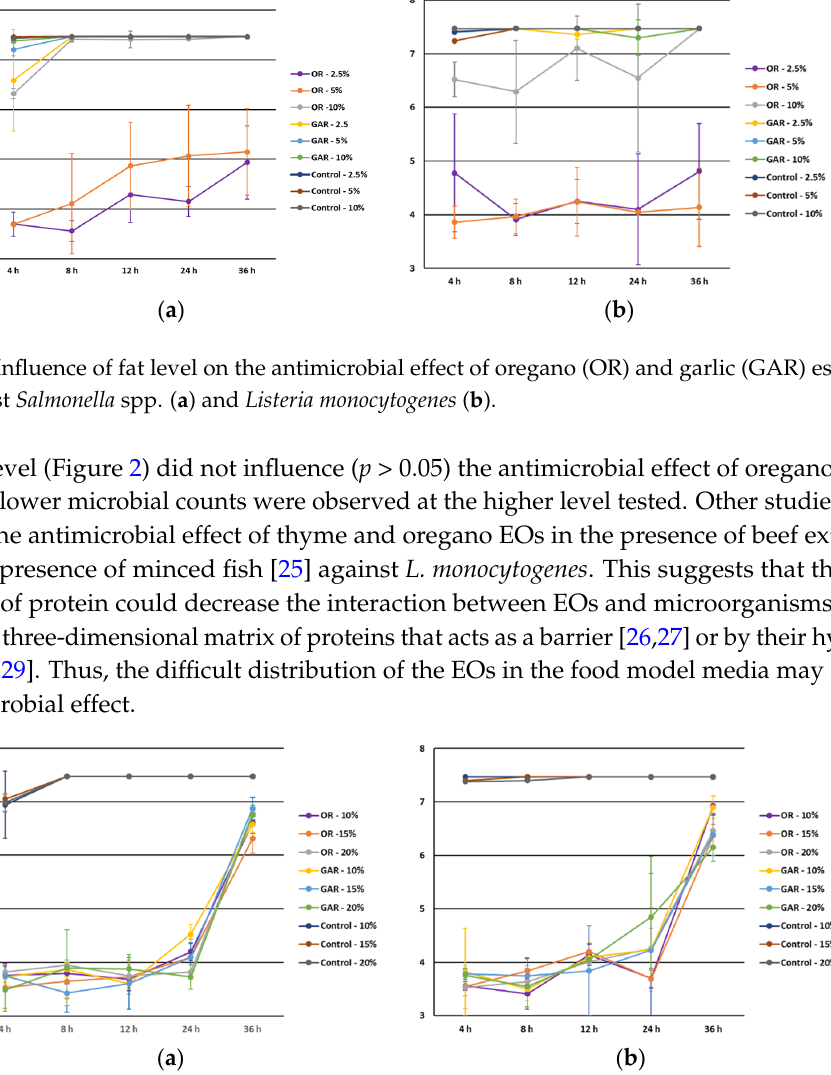
Figure 2. Influence of protein level (Prot) on the antimicrobial effect of oregano (OR) and garlic (GAR) essential oils against Salmonella spp. ( a ) and Listeria monocytogenes ( b ).